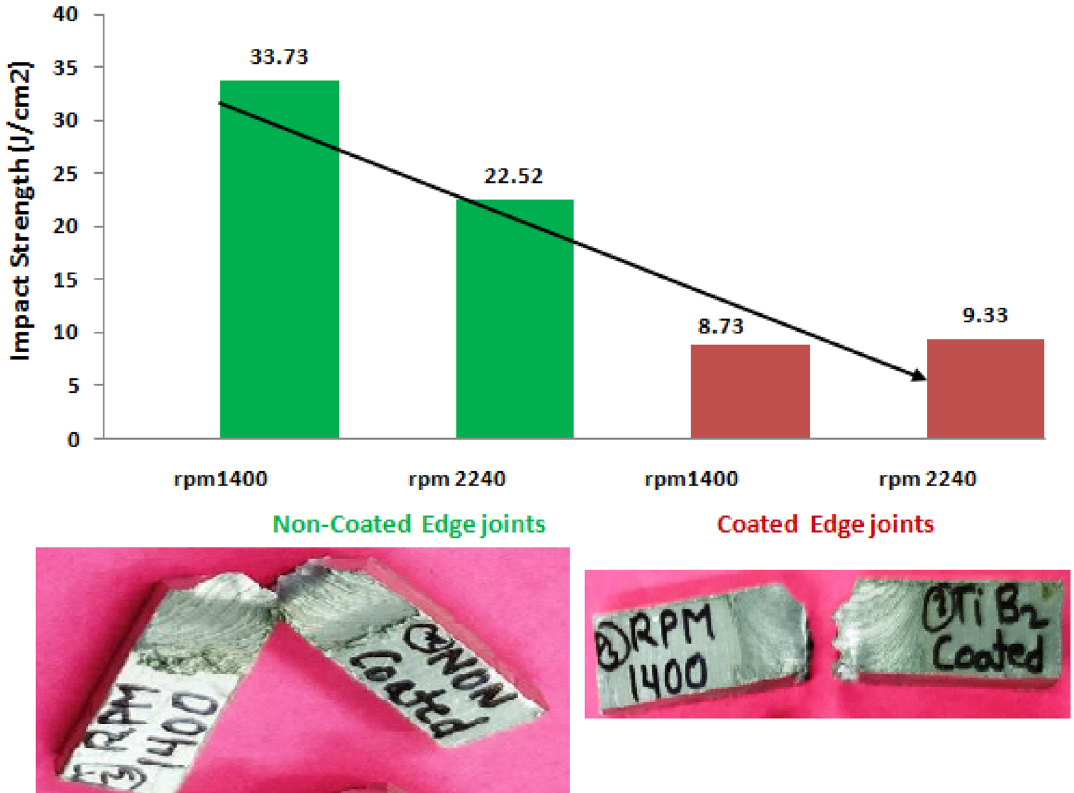
Figure 16. Impact strength of welded joints at varying rpm.